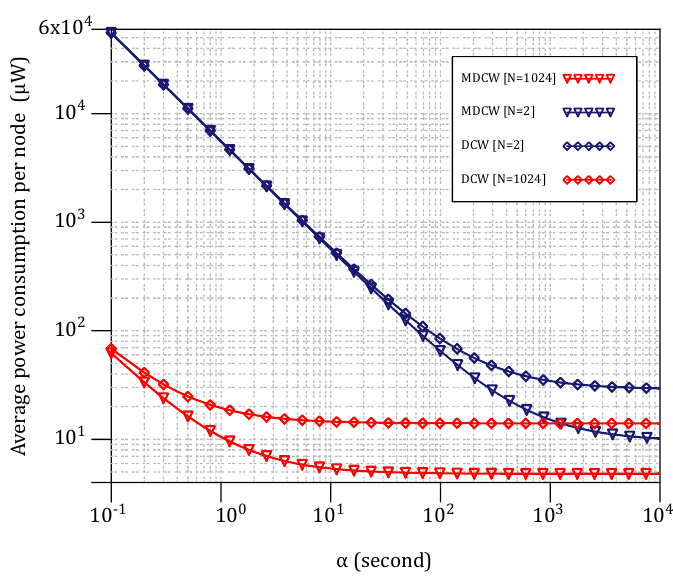
Figure 17. MDCW-MAC and DCW-MAC average power consumptions per node against the α interval for different WSN configurations.